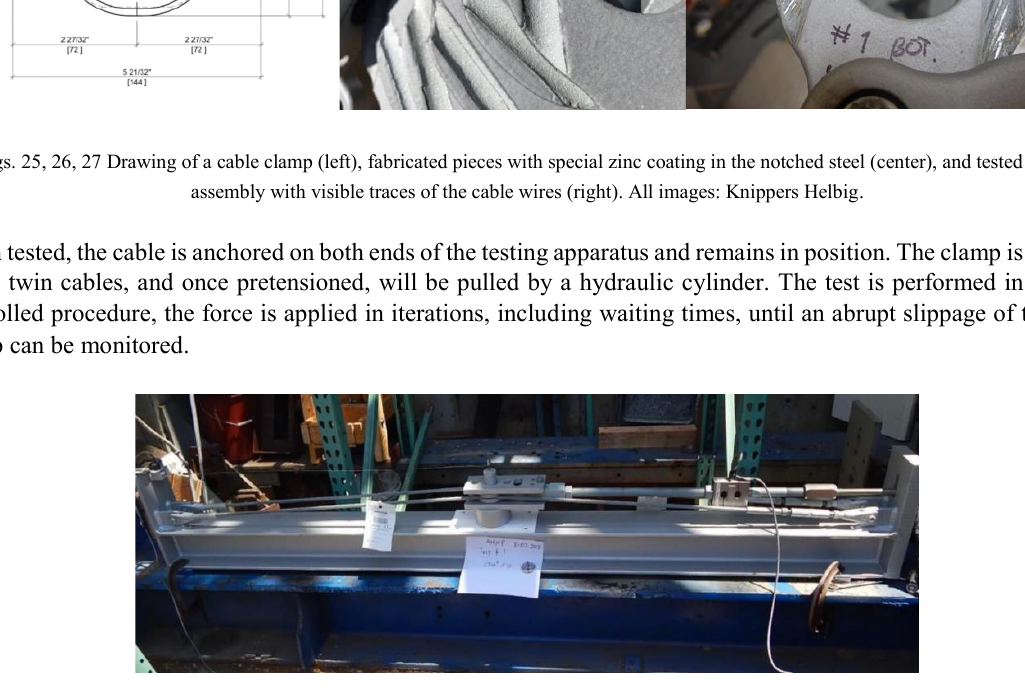
Figs. 28, 29 Testing apparatus at Smith Emery Laboratories, L.A.. Image: Knippers